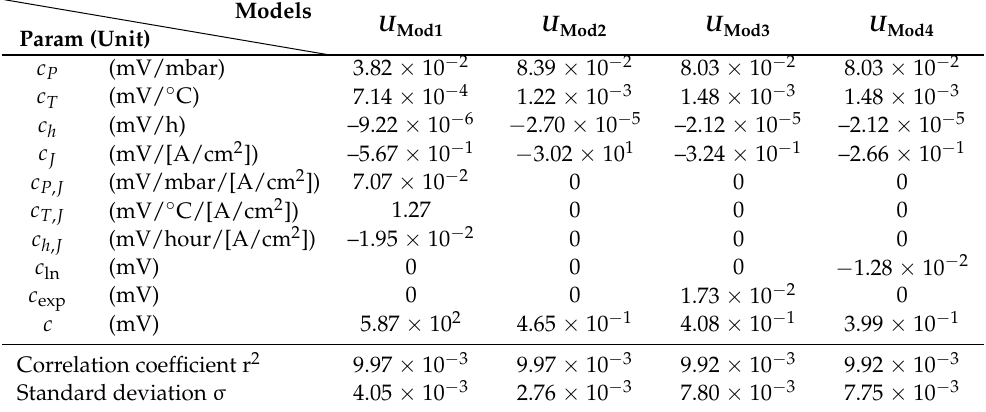
Table 2. Values of the model coefficients used in Equations (3)–(6) and corresponding regress ion